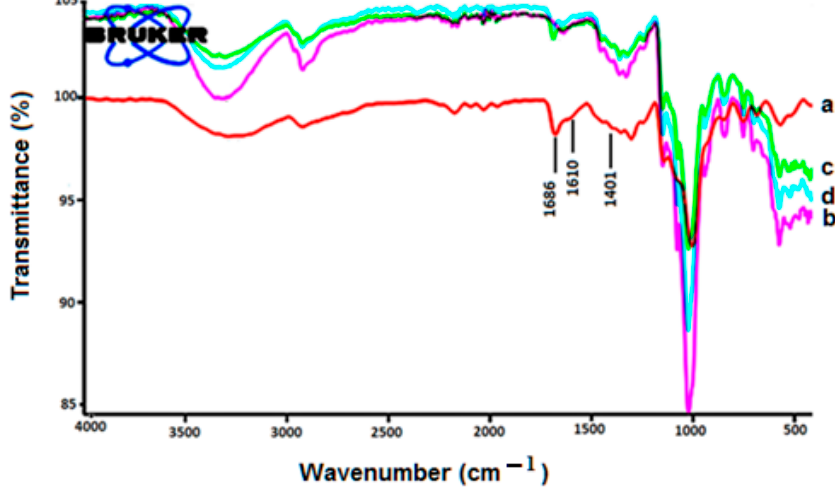
Figure 5. FTIR of FLB (a), HP- β -CD (b), physical mixture (c), complex (d).